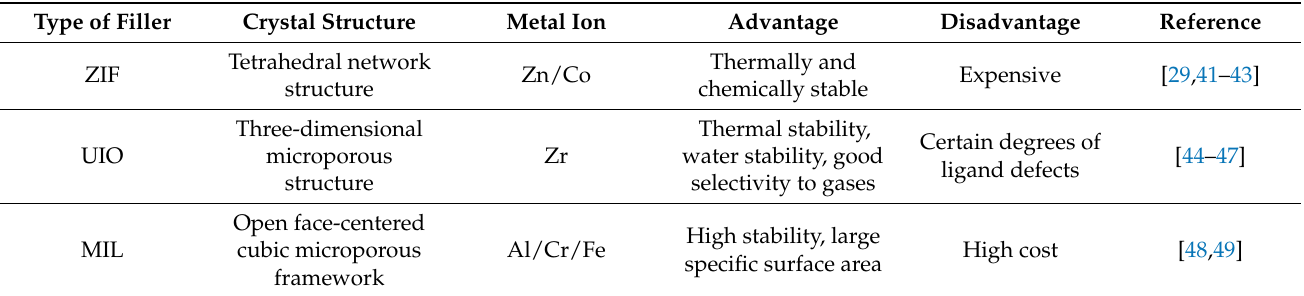
Table 2. Characteristics of common MOF